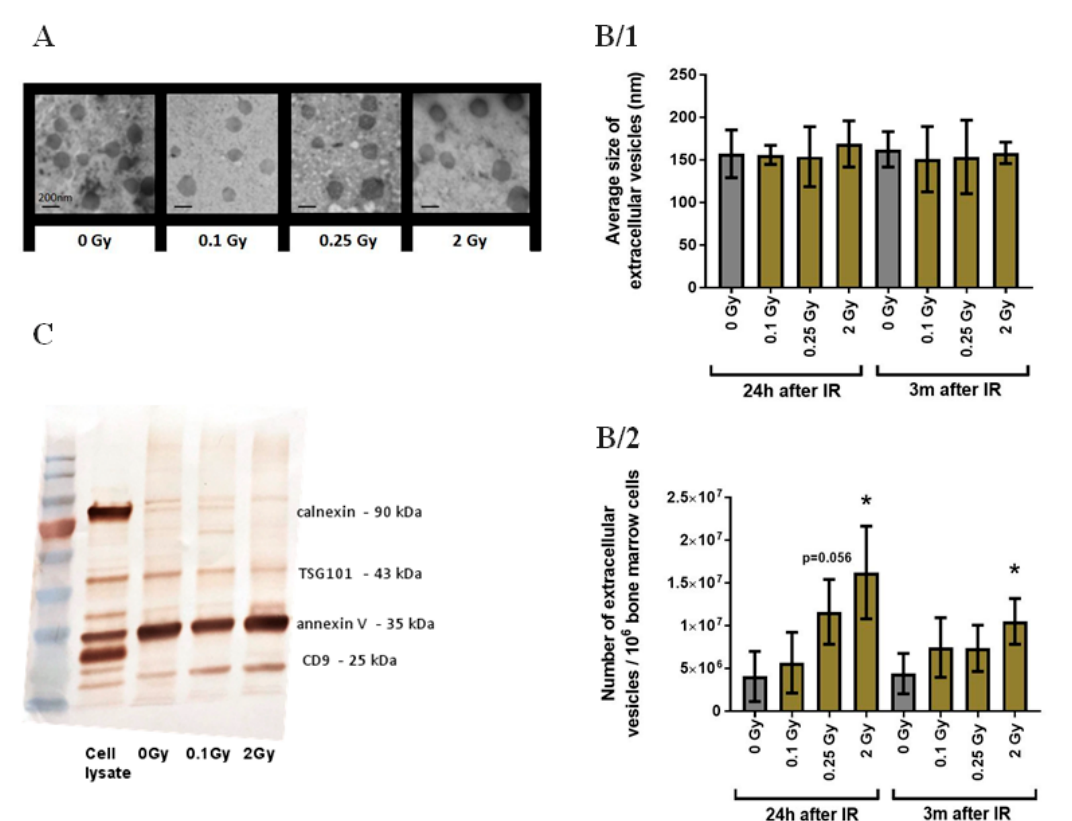
Figure 2. Characterization of Bone Marrow-Derived Extracellular Vesicles. ( A ) Representative transmission electron microscopy images of extracellular vesicles isolated from the bone marrow of mice irradiated with the indicated doses of ionizing radiation. ( B ) Size and concentration of extracellular vesicle suspensions were examined by tunable resistance pulse sensing. Mean values of extracellular vesicle size ( B/1 ) and mean extracellular vesicle particle numbers released by 10 6 bone marrow cells ( B/2 ) are shown with bars representing standard deviations (SD). n = 3, significance tested by Student’s t -test, p * < 0.05. ( C ) Representative Western blot analysis of whole cell lysates and extracellular vesicles isolated from the bone marrow of mice irradiated with the indicated doses of ionizing radiation. Lane 1: protein ladder, lane 2: whole cell lysate, lane 3: extracellular vesicle sample from unirradiated mice, lane 4-5: extracellular vesicle samples from mice irradiated with 0.1Gy and 2Gy.